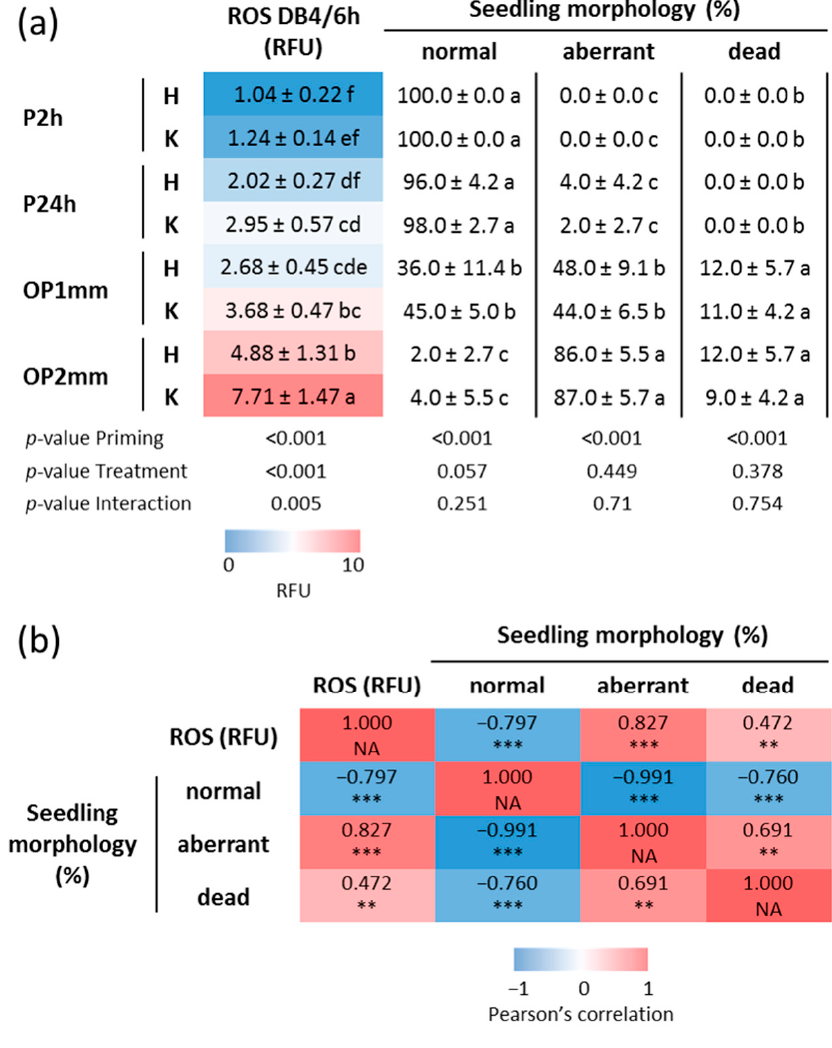
Figure 7. Proof-of-concept to verify the positive correlation between ROS levels and the loss of desiccation tolerance in M. sativa . ( a ) ROS levels measured by DCF-DA assay at the endpoint of dry-back (DB4/6h) of M. sativa seeds and occurrence of ‘normal’, ‘aberrant’ and ‘dead’ seedling morphology in response to short/prolonged priming and mild/severe overpriming. RFU (relative fluorescence units) and the percentage of seedling morphology occurrence are expressed as mean values ± standard deviation. p -values are also provided referring to the comparisons between priming protocols (P2h vs. P24 vs. OP1mm vs. OP2mm), treatment groups (H vs. K), and their interaction, as analyzed with two-way ANOVA and Tukey test. Within each column, values that are followed by common letters are not significantly different ( p -value < 0.05). P2h, 2 h-priming; P24h, 24 h-priming; OP1mm, hydroprimed seeds with 1 mm radicle protrusion; OP2mm, hydroprimed seeds with 2 mm radicle protrusion; H, hydropriming; K, hormopriming; RFU, relative fluorescence units. ( b ) Correlation analysis carried out between the ROS emission at the endpoint of dry-back and the seedling morphology in M. sativa . The Pearson’s correlation coefficients are indicated. The significance of the Pearson’s correlation is shown by asterisks (‘**’ p < 0.01, ‘***’ p < 0.001). NA, not applicable.